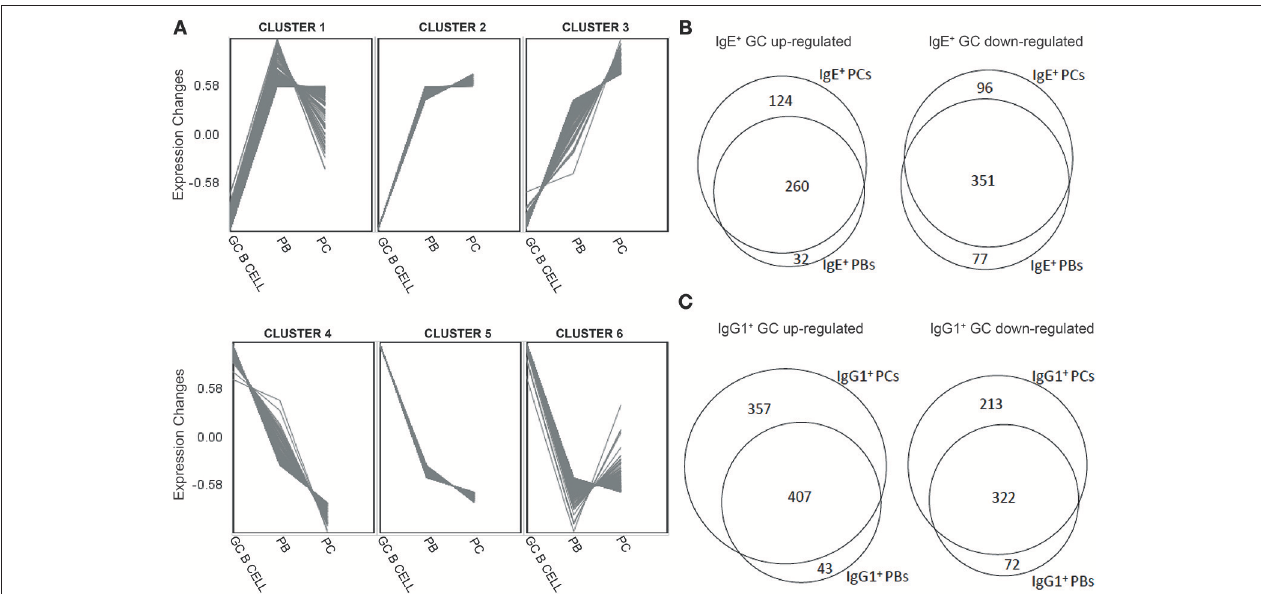
FIGURE 2 | Distinct gene expression patterns and identification of genes unique different stages of B cell differentiation into PCs. (A) Clustering of genes differentially expressed along the differentiation pathway of B cells into PCs regardless of the Ig isoform was undertaken by the production of unsupervised Self-organizing Maps (SOM). (B) Venn diagrams showing overlaps and differences between genes that were significantly ( p < 0.05) up-regulated or down-regulated by > 1.5-fold in IgE + cells along their differentiation pathway into PCs. (C) Venn diagrams showing overlaps and differences between genes that were significantly ( p < 0.05) up-regulated or down-regulated by > 1.5-fold in IgG1 + cells along their differentiation pathway into